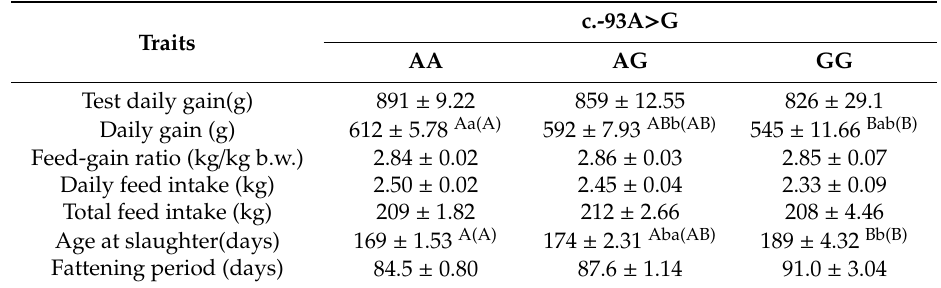
Table 7. Di ff erences in growth and fattening traits between pigs with di ff erent genotypes at the locus c.-93A > G (LSM ± SE).